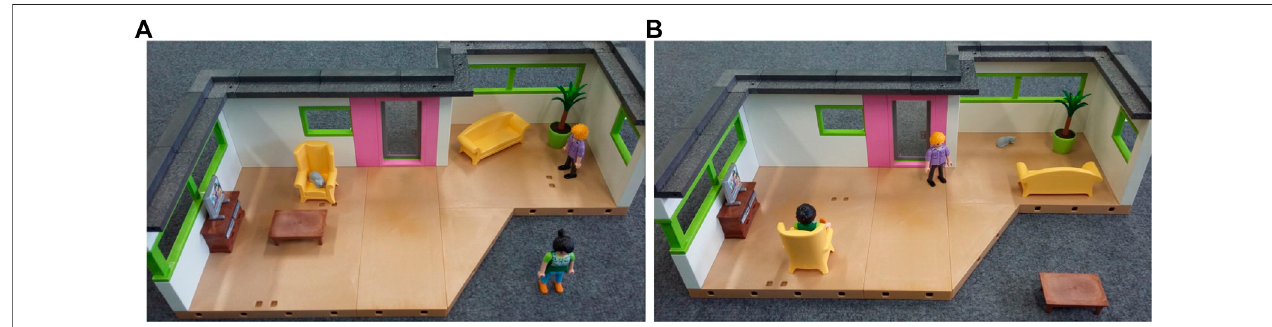
FIGURE2| TwoexamplesofitemsetupinthePlaymobillivingroom.Fiveitemsareplacedindifferentlocationsintheroom, oneitemwasalwaysleftonthesideas the distractor (and did not need to be placed by the